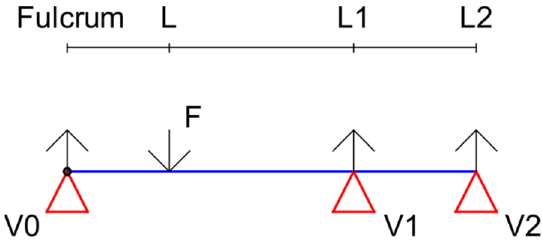
Figure A3. Hyperstatic beam representation.